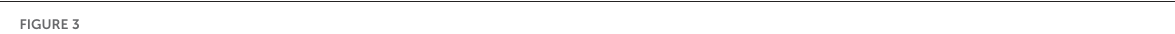
FIGURE3 and TLR2 − / − mice that received a double inflammatory stimulus [NA ICV and LPS or P3C IP, (B) ] had increased astrocytes density compared to animals of the same genotype receiving a single inflammatory stimulus [LPS/P3C in (A) or Sham groups in (B) ]. However, TLR4 − / − mice displayed similar numbers of astrocytes in mice treated with two stimuli [NA ICV and P3C, (B) ] and in those treated with a single one [P3C in (A) and Sham in (B) ]. Micrographs show representative images of GFAP labeled sections from ICV Saline (C–I) and ICV NA (J–P) animals. Bars in histograms represent the mean ± s.d. of the plotted points [each point represents data from one mouse; n = 3–4 in (A) and n = 5–7 in (B) ]. Means were compared by three-way ANOVA (P = 0.007). Letters a and b on top of the bars designate the absence (if the same letter appears) or existence (if different letters appear) of a significant difference between the compared groups, carried out by Tukey’s test ( P <